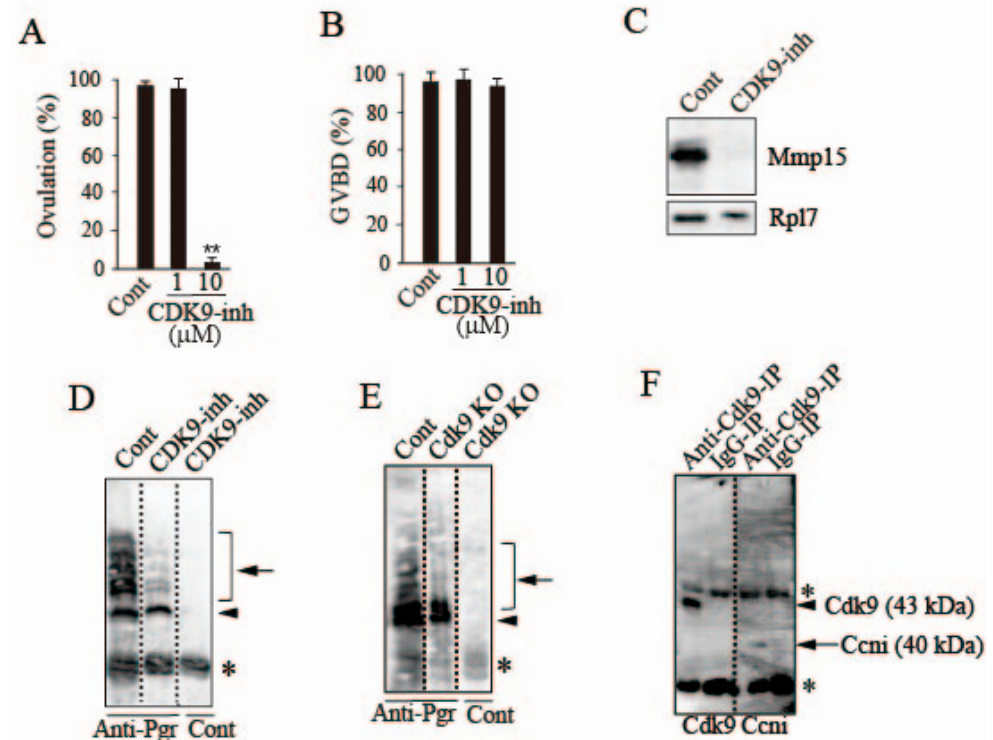
Figure 7. Further evidence for the role of Cdk9/Ccni in the follicles that are destined to ovulate. ( A ) The − 14 h-follicles were incubated in vitro with the specific CDK9 inhibitor, CDK9-inhibitor II, at 1 and 10 µ M for 18 h, and the rate of ovulation was determined. Asterisks indicate significance at p < 0.01 (**) compared to follicles incubated without any additives (ANOVA and Dunnett’s post hoc test, N =